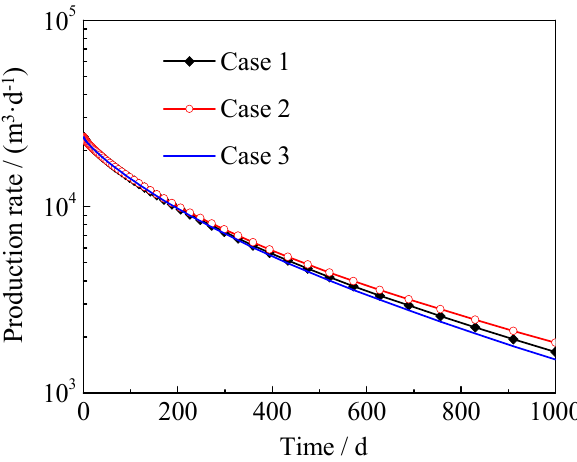
Figure 8. Influence of radius-changing during decompression production on gas flow rate.